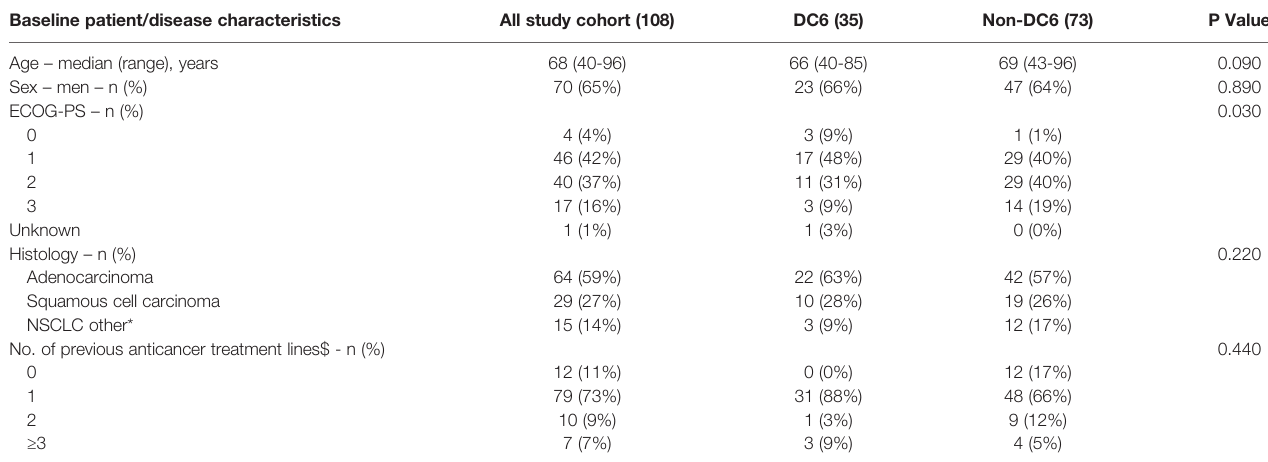
TABLE 1 | Baseline patient and disease characteristics. Baseline patient/disease